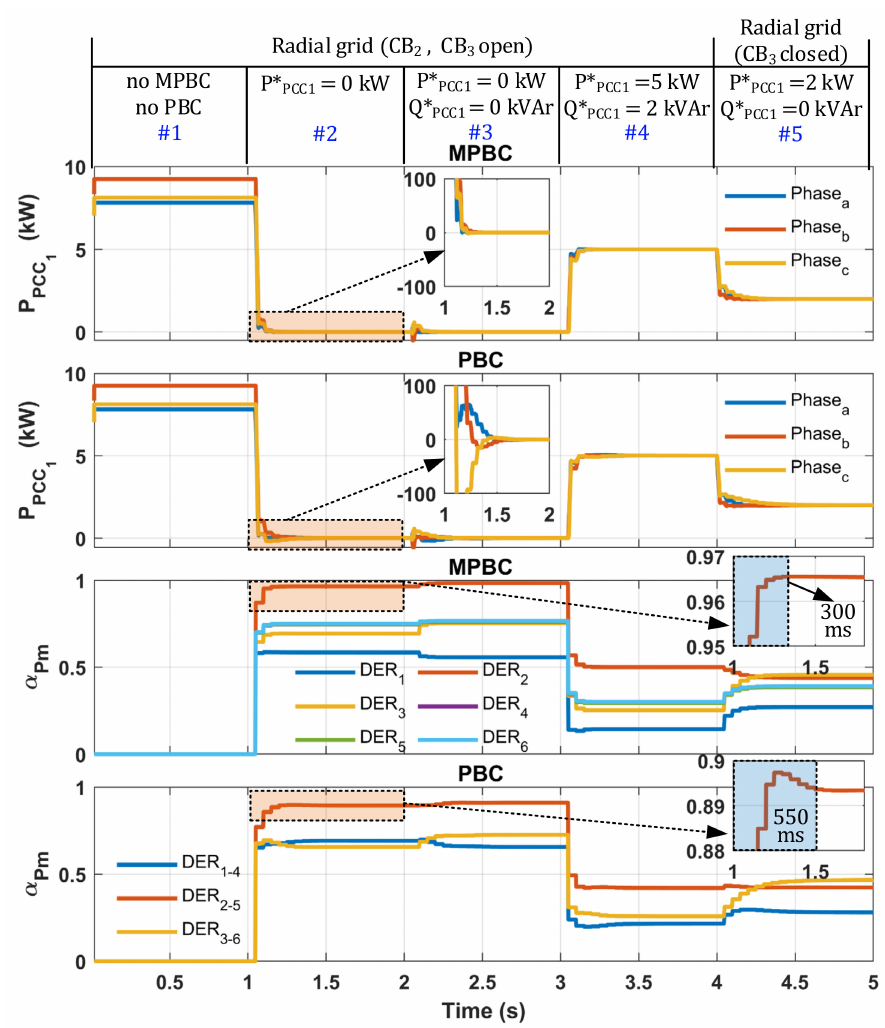
Figure 4. Active power in PCC 1 and scalar coefficients ( α pm ) for MPBC and PBC. During all intervals the µ G assumes the radial topology, but between intervals #1 and #4 it is supplied only by PCC 1 . Then, during interval #5 the µ G is supplied by PCC 1 and PCC 2